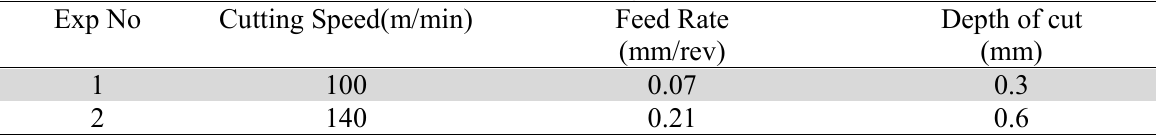
Parameters used in the confirmation test for surface roughnes s